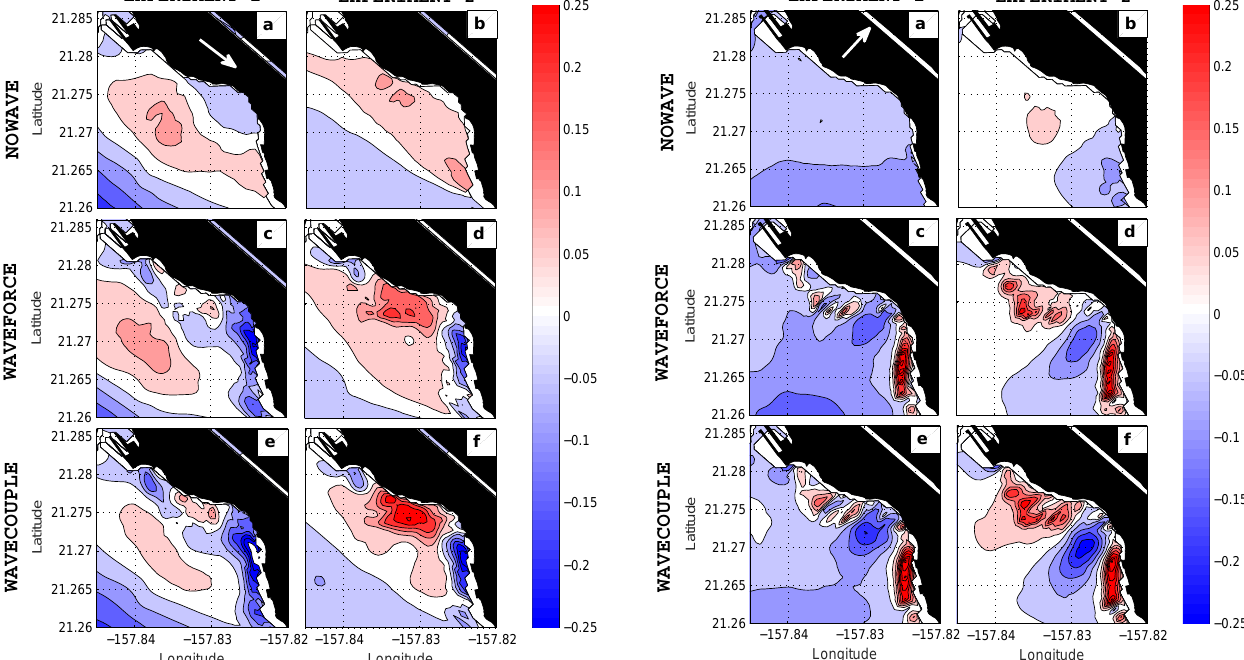
Figure 6. Time-averaged alongshore currents (ms − 1 ) in Waikiki region for experiment 1 (a, c, e) and experiment 2 (b, d, f) from the three modeling strategies. The colors indicate the current inten- sity (ms − 1 ) with contours every 0.05ms − 1 . It is interesting to ob- serve the appearance of drift currents along the coast in the simula- tions that consider the effect of the surface waves. Both the WAVE- FORCE and WAVECOUPLE simulations resolve the modification of the nearshore circulation pattern by the waves, with WAVECOU- PLE presenting stronger coastal drift currents. The white arrow in panel (a) shows the direction of positive alongshore velocities.